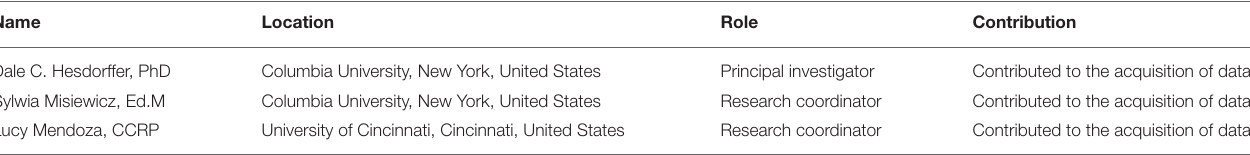
TABLE A1 | MS-BioS study